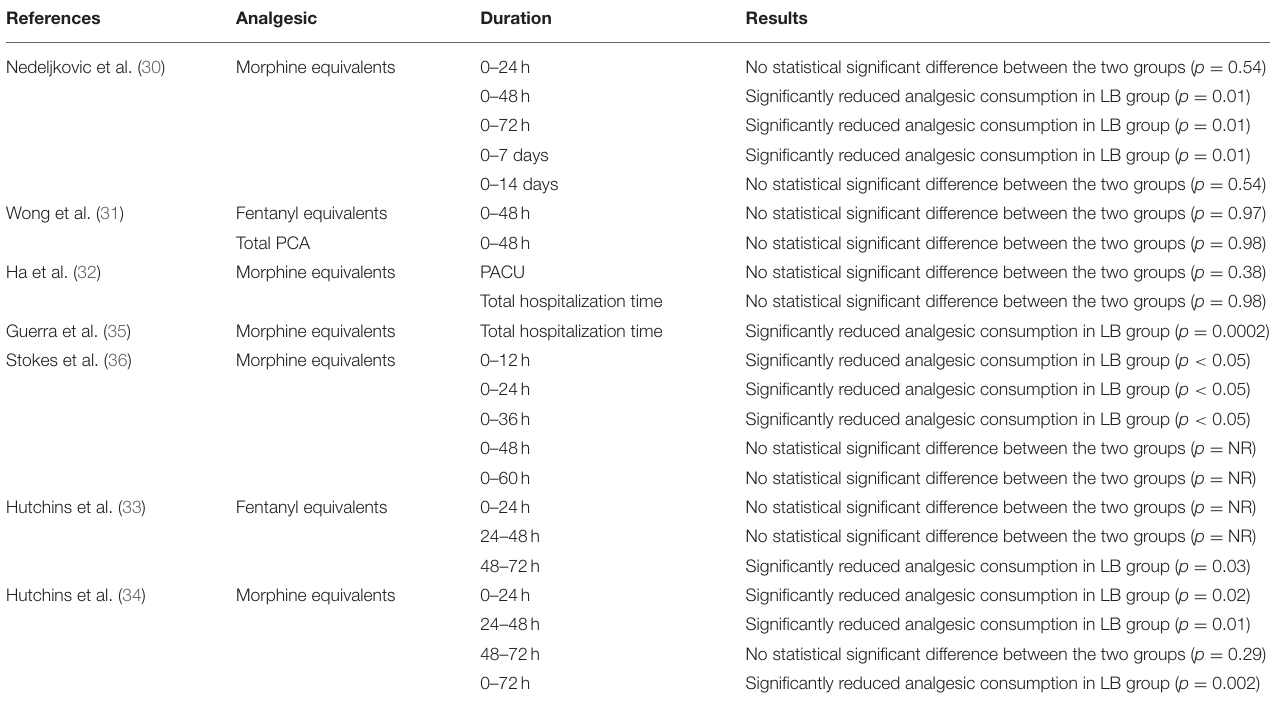
TABLE 3 | Outcome of “total analgesic consumption” reported by the included